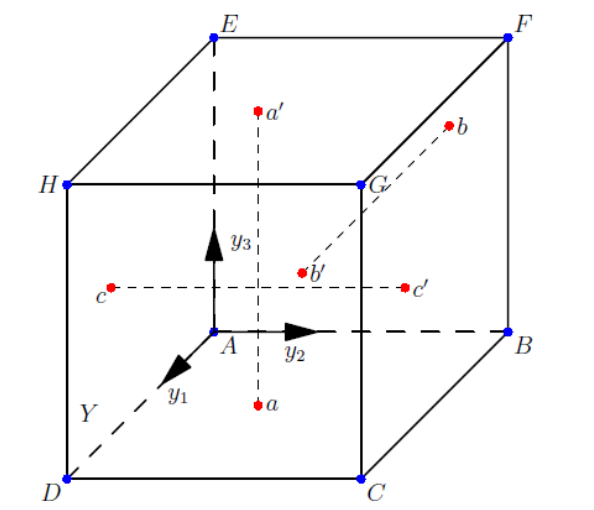
Figure 2. Periodic boundary conditions. Table 1. Material